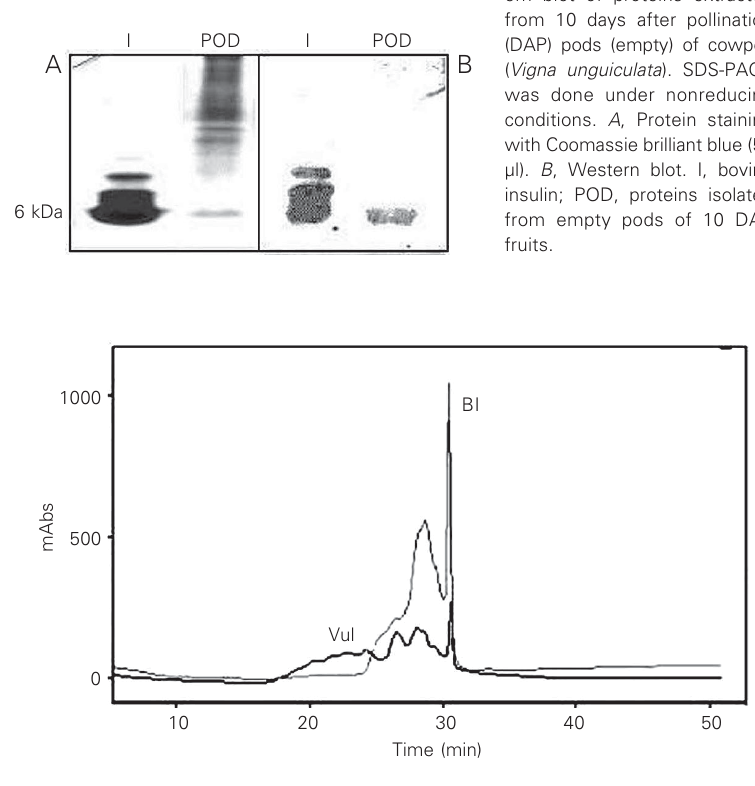
Figure 2. Reverse-phase HPLC separation of bovine insulin (BI, 300 µg) and of insulin isolated from empty pods of 10 days after pollination fruits of Vigna unguiculata (VuI, 50 µg). The column was operated at 0.7 ml/min and proteins were detected by absorbance at 280 nm and a gradient of acetonitrile and 0.1% TFA was applied to the column as described in Methods. The light line indicates the elution profile of insulin and the dark line, the profile of the cowpea